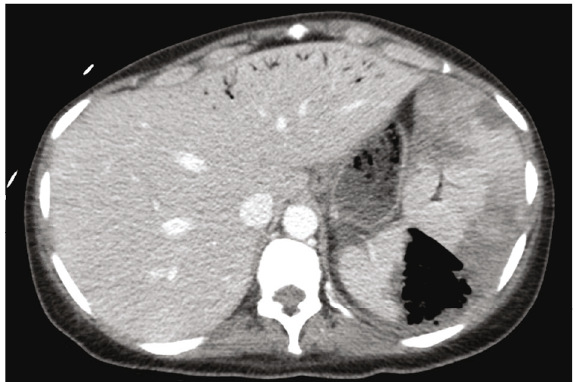
Figure 1: Axial CT image showing a markedly enlarged spleen (20 cm) with multiple areas of hypoattenuation indicating infarction, as well as a large wedge-shaped area of intrasplenic